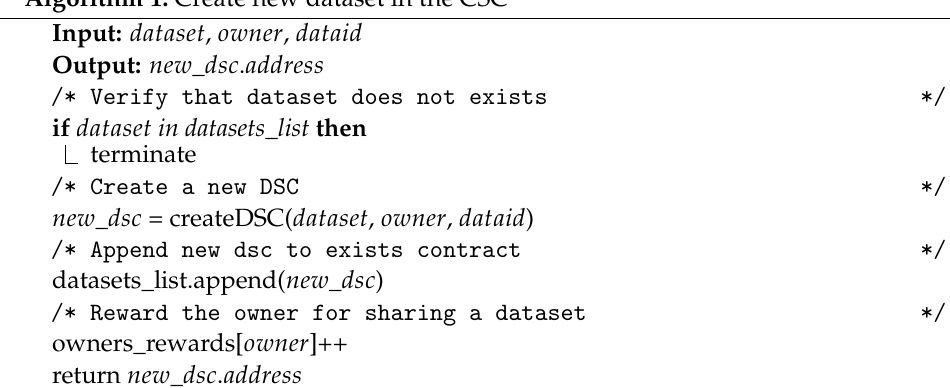
Algorithm 1: Create new dataset in the CSC